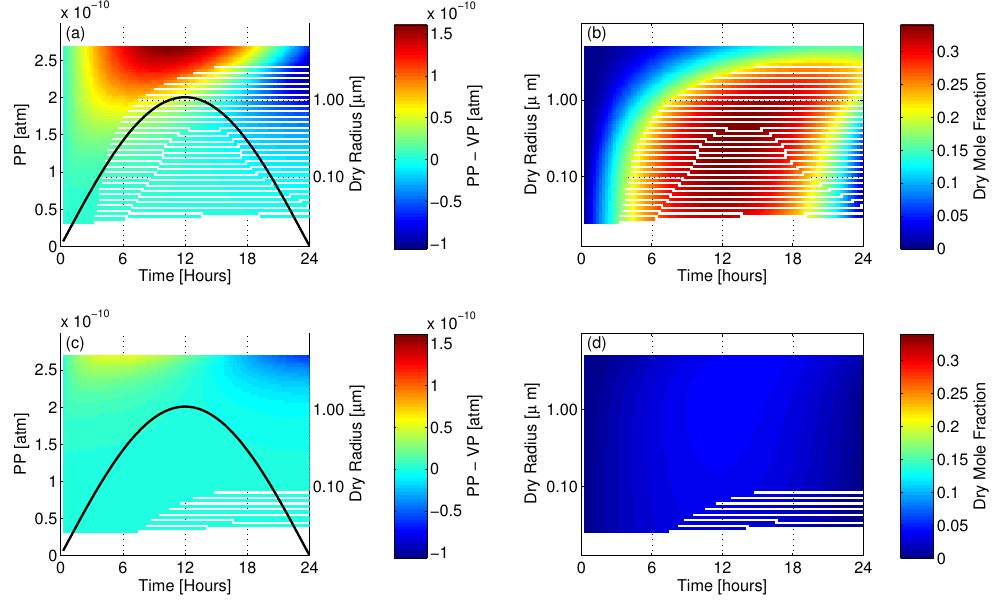
Fig. 7. Evolving condensed phase abundance and gas phase concentration for compound “8” as a function of time, assuming ideality ( a and b ) and using PD-FiTE ( c and d ). Panels (a) and (c) show the size-resolved differences between vapour pressure (VP) over aerosol particles and the gas-phase partial pressure (PP) (red indicates higher partial pressures; blue indicates higher vapor pressures), as well as the temporal variation in the partial pressure of compound “8” (black line). Panels (b) and (d) show the size-resolved dry mole fractions of compound “8” within the condensed-phase.